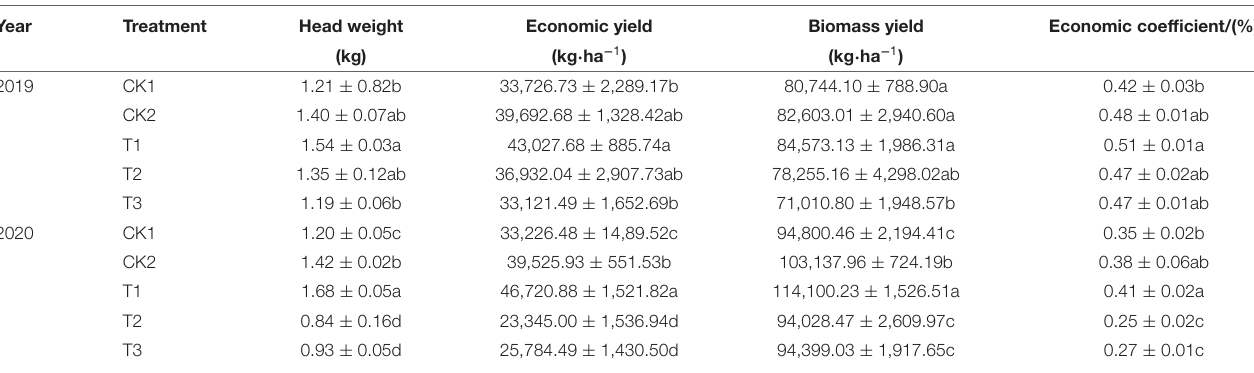
TABLE 3 | Effects of different ground mulching patterns on loose-curd cauliflower